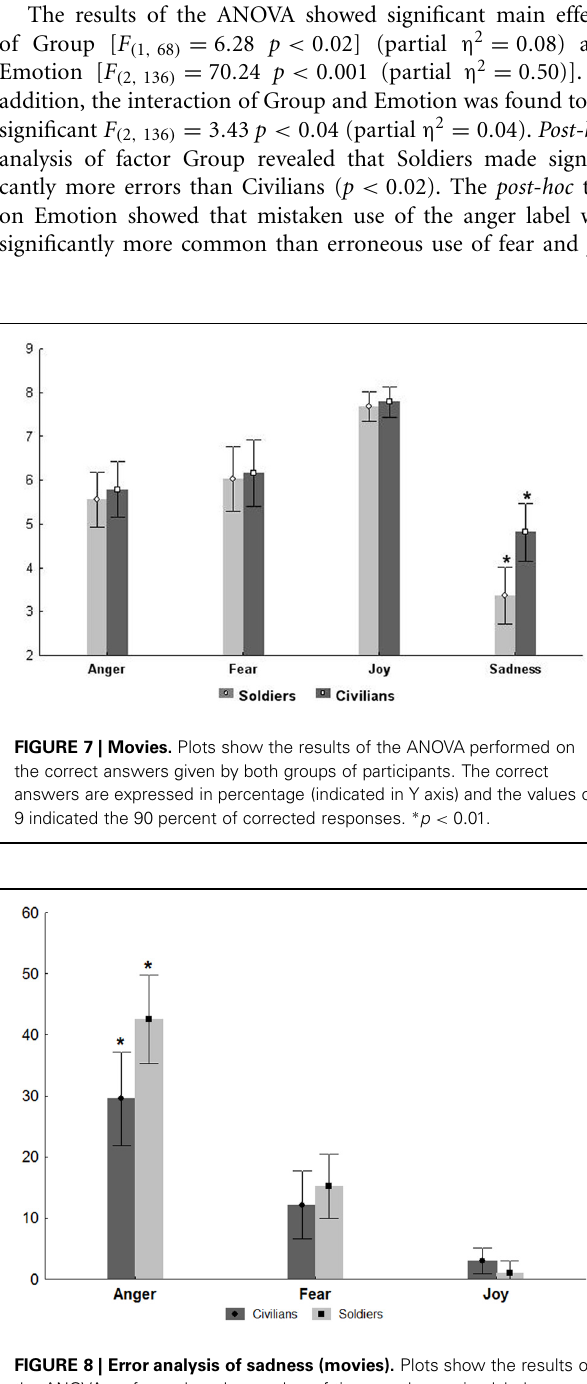
FIGURE 8 | Error analysis of sadness (movies). Plots show the results of the ANOVA performed on the number of times each emotion label occurred as an incorrect response to the presentation of sadness. The incorrect responses are expressed as percentage (indicated in Y axis). ∗ p < 0 .